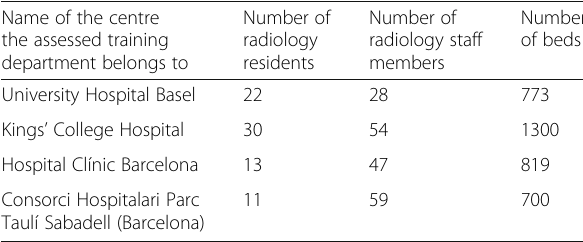
Table 1 ETAP 2.0 certified centres, number of radiology residents, radiology staff members and number of beds (as of October